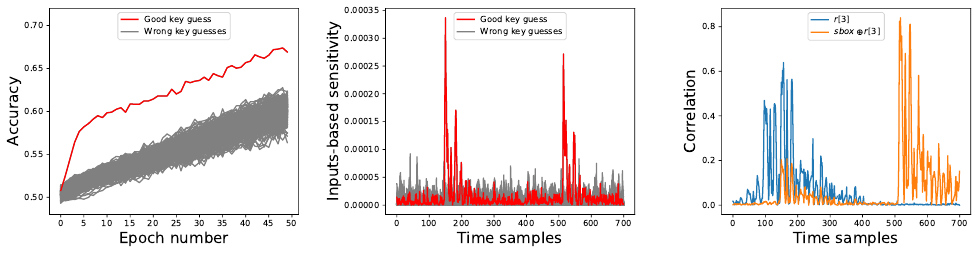
Figure 11: MLP-DDLA attack on ASCAD. Left: Accuracy. Center: Inputs-based sensitiv- ity. Right: CPA reverse